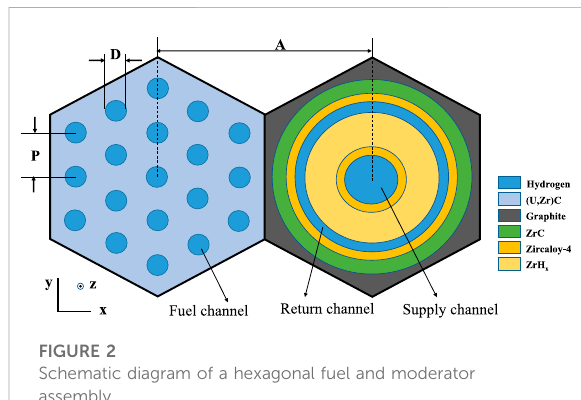
FIGURE 2 Schematic diagram of a hexagonal fuel and moderator